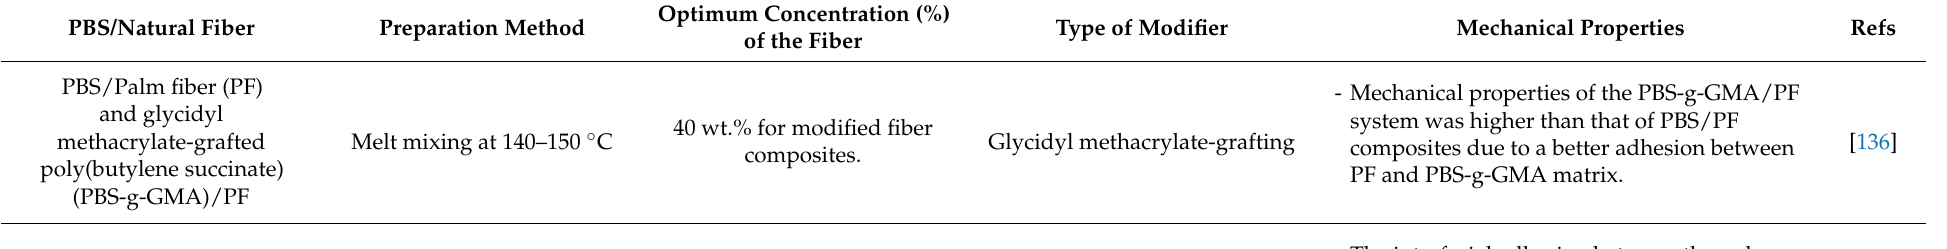
Table 5. Comparison of the selective studies on the optimum content of the fiber on the mechanical properties of the PBS/natural fiber